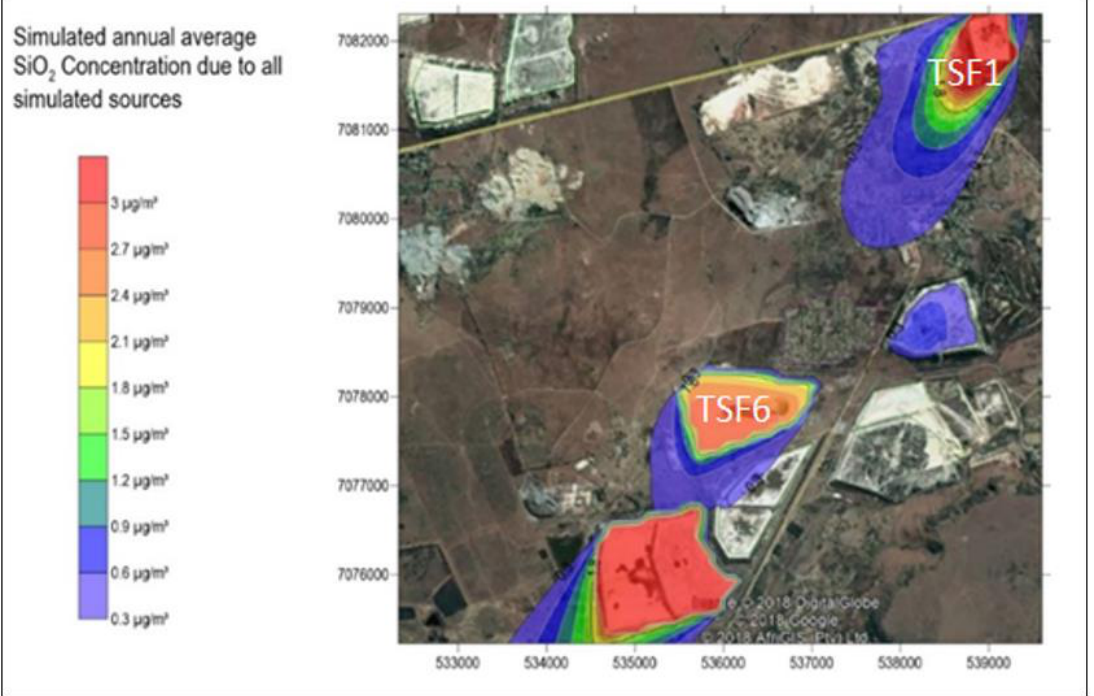
Figure 10. Simulated annual average SiO2 concentration due to all simulated sources.